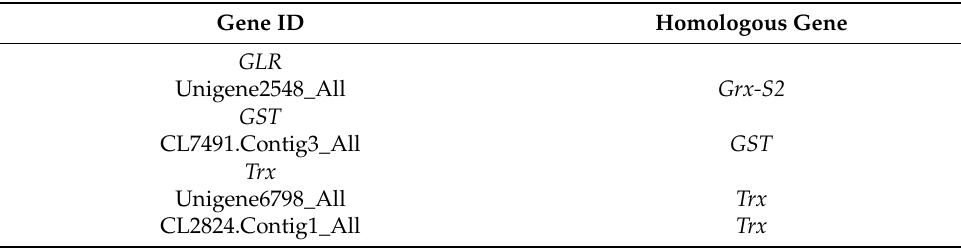
Table 6. The upregulated DEGs related to the ROS scavenging system in the roots of A. canescens under 100 mM NaCl for both 6 and 24 h.